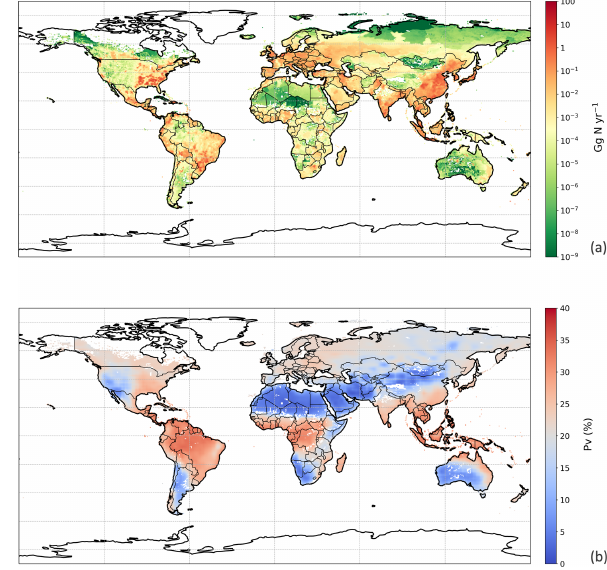
Figure 9. Simulated (a) annual global NH 3 emissions (GgNyr − 1 ) from chicken housing in 2010. (b) Percentage of excreted nitro- gen that volatilizes ( P V ) as NH 3 from chicken housing in 2010. The resolution is 0 . 5 ◦ × 0 . 5 ◦ . For the simulation shown, the RH pa- rameterization for UA hydrolysis is taken from Elliott and Collins (1984). Figure S9 shows the results of using the RH parameteriza- tion, based on new parameterization from AFO monitored data (for